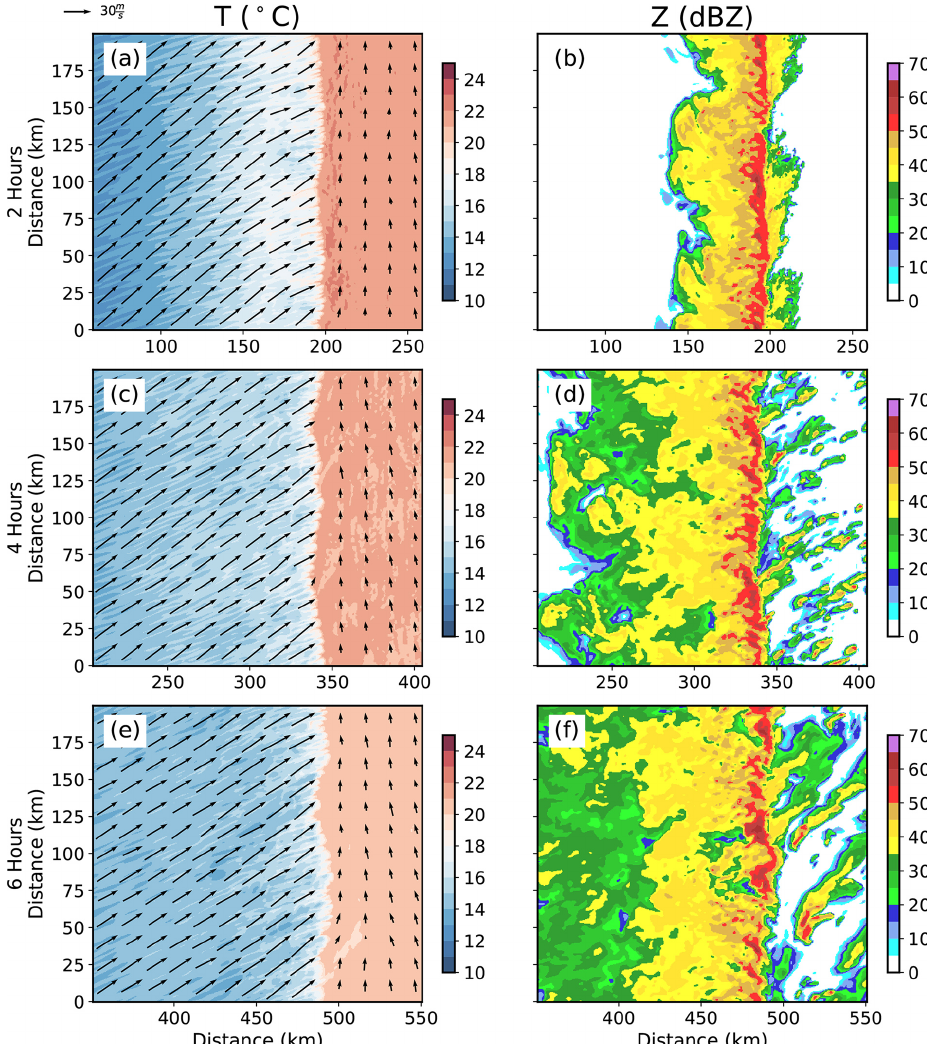
Figure 4. Nature run (a, c, e) T and (b, d, f) Z at the lowest model level (5ma.g.l.). The 500ma.g.l. winds are superimposed (a, c, e) using